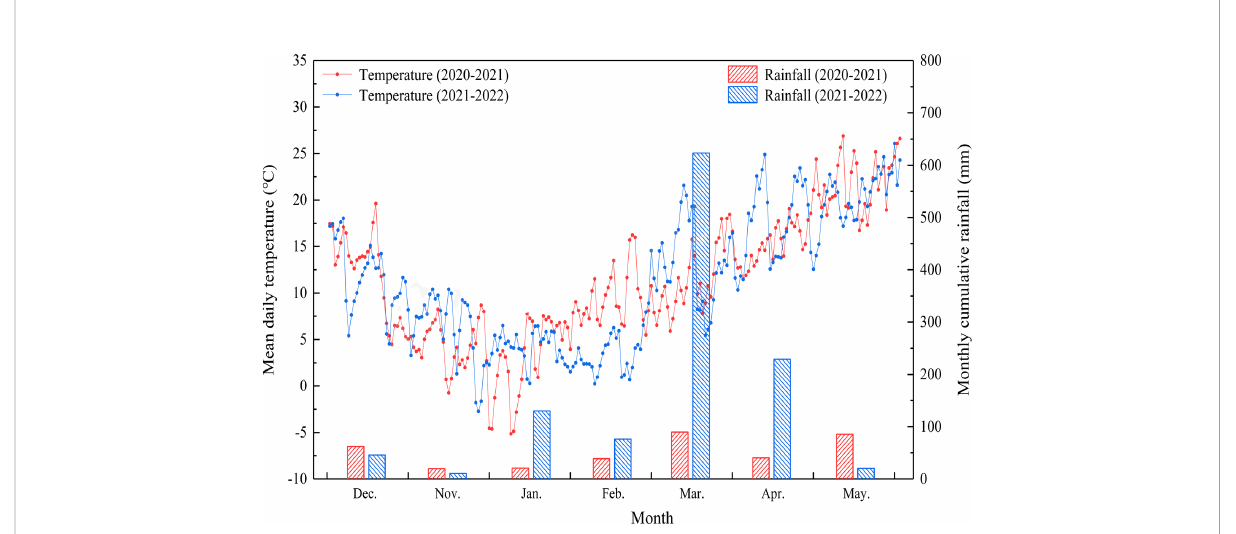
FIGURE 1 The mean daily temperature and monthly cumulative rainfall during wheat growing seasons (2020 –